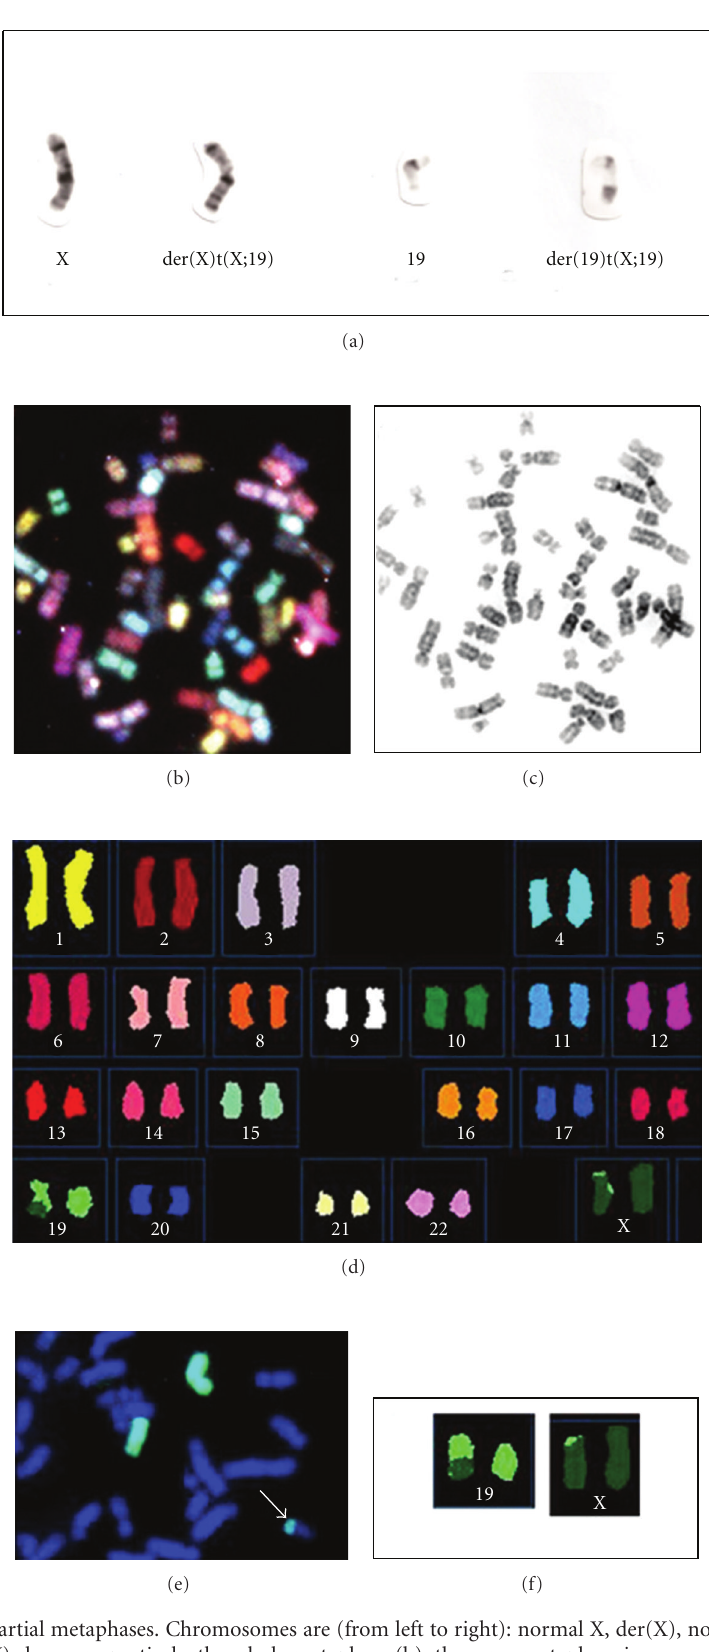
Figure 2: (a) GTG-banded partial metaphases. Chromosomes are (from left to right): normal X, der(X), normal 19, and der(19). (b, c, d, f) Spectral Karyotyping (SKY) shows, respectively, the whole metaphase (b), the same metaphase in reverse G banding (c), spectra-based colors following classification (d), and detailed characterization of the abnormal chromosomes (f). (e) FISH using X-chromosome